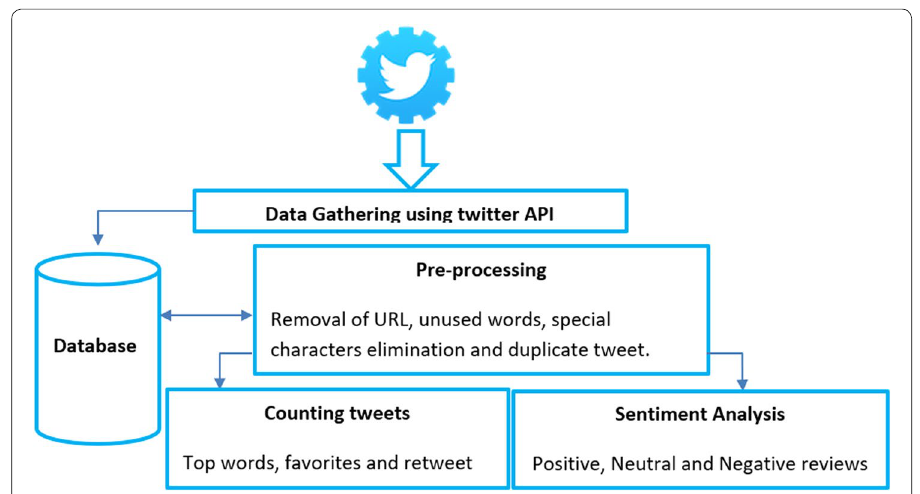
Fig. 2 Framework for prediction of Presidential election using Twitter